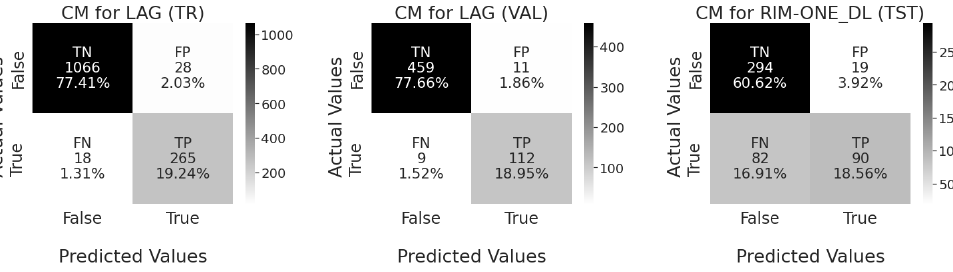
Figure 8. Confusion matrix of Squeezenet trained parameters for